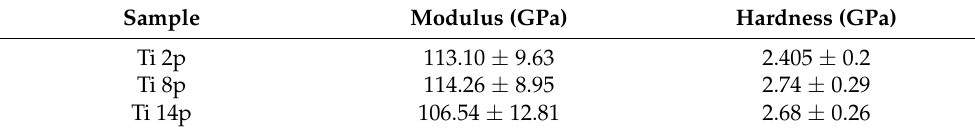
Figure 10. Roughness of TiN thin film on cold-spray Ti samples: ( a ) 2p, ( b ) 8p, and ( c ) 14p. Table 2. Nano-indentation results of Ti cold spray samples.